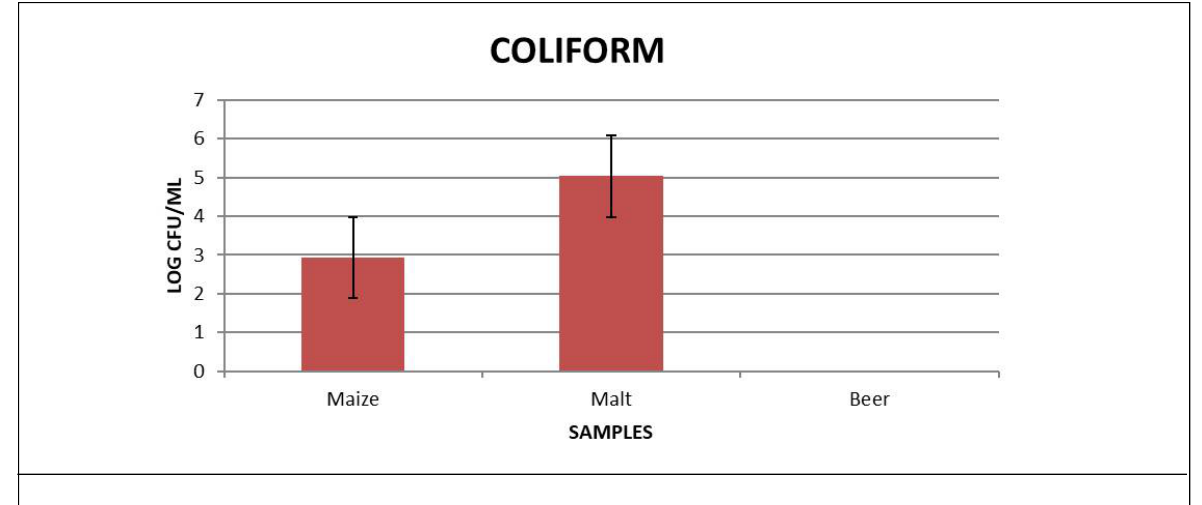
Figure 4: Coliform count in maize, malt and beer